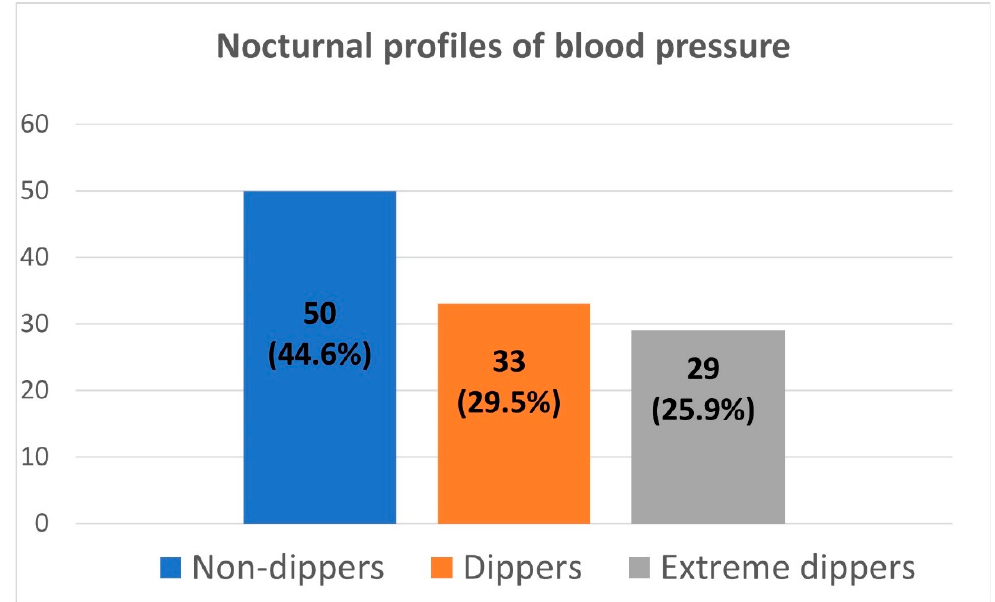
Figure 1. Dipping patterns distribution among studied population (numbers of patients). The parameters of hypertension-mediated organ damage were presented in Table 4. Left ventricular hypertrophy was revealed in 26/112 (23%) patients, abnormal aPWV in 5/112 (4%), abnormal AIx75HR in 24/112 (21%), abnormal cIMT in 22/112 (20%),